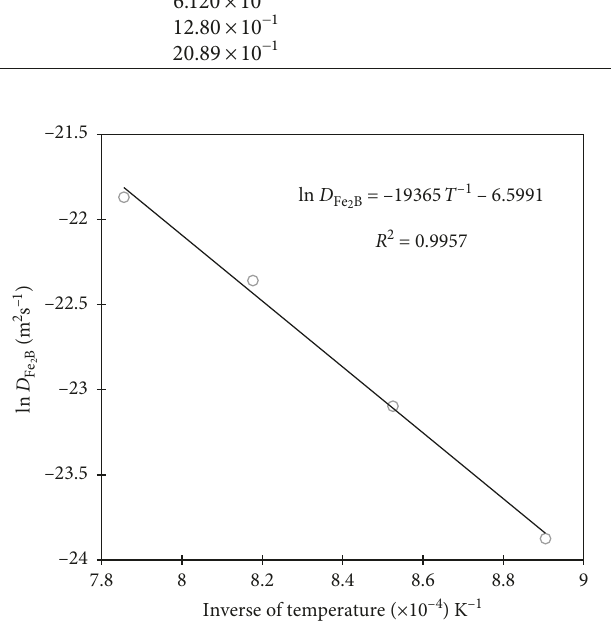
Figure 8: Arrhenius relationship for the boron diffusion coefficient ( D Table 2: Estimated values of boron diffusion coefficients in the Fe Temperature